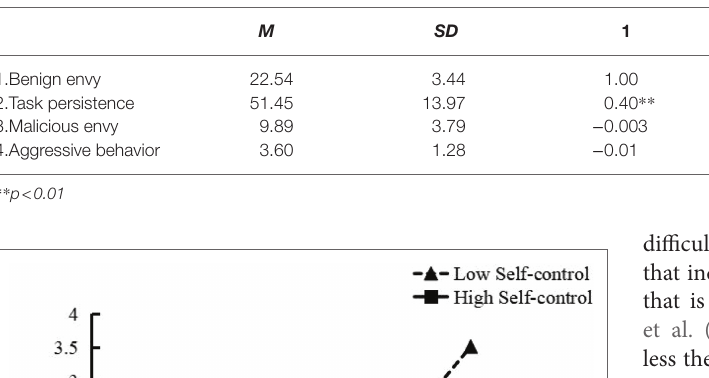
TABLE 3 | Descriptive statistics and correlation coefficients for each variable.